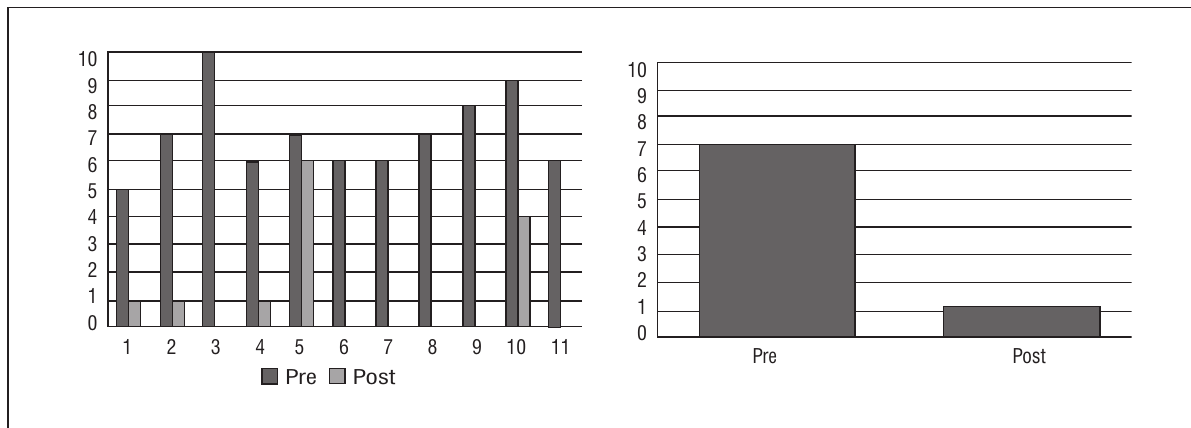
Figure 2 - Visual Analogue Scale (VAS) for pain. (A) Individual results of patients before treatment (VAS_ pre) and after 12 weeks of treatment (VAS_ post). (B) Average values evidence a statistically significant reduction (p < 0.001) at the final